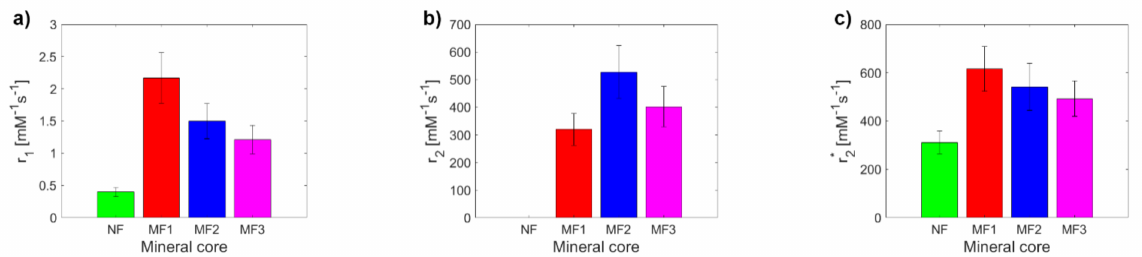
Figure 1. Comparison of relaxivity values of NF and MF samples: ( a ) longitudinal relaxivity r 1 ; ( b ) transverse relaxivity r 2 ; ( c ) transverse relaxivity r 2 *